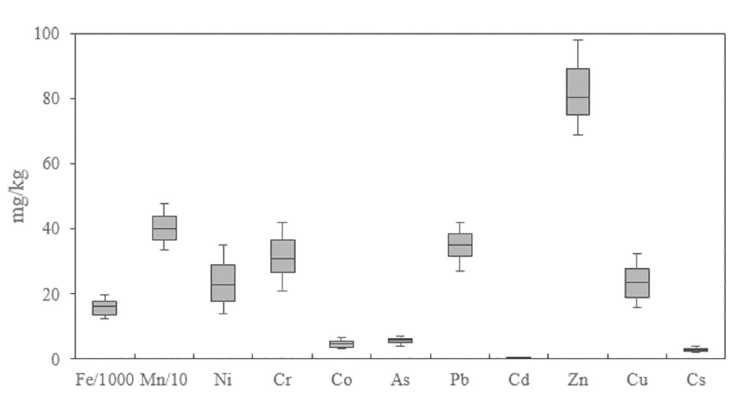
Fig 2. Box-Plot of the heavy metal concentrations in urban soil. (To display all the elements in an axis, the values of Fe and Mn are divided into 1000 and 10, respectively).